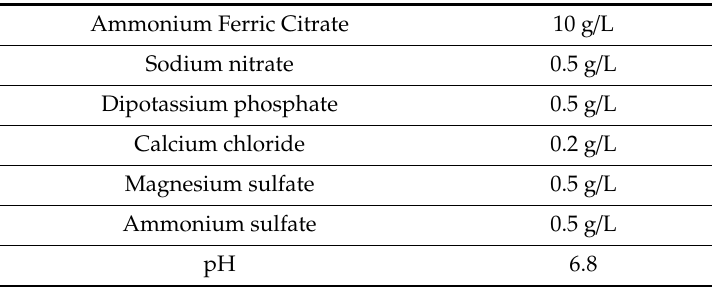
Table 4. The medium composition of iron bacteria.